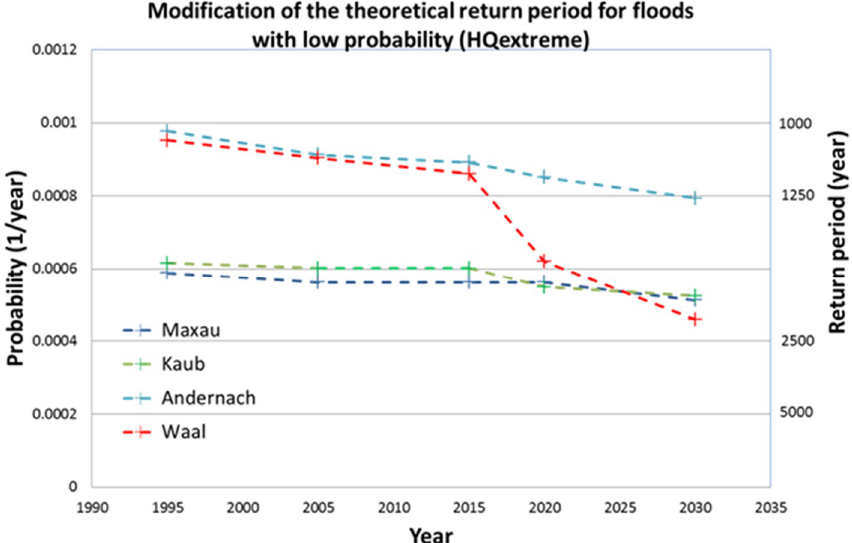
Figure 7. Change of probability (left hand y -axis) and return period (right y-axis) for the extreme flood event at four gauging stations